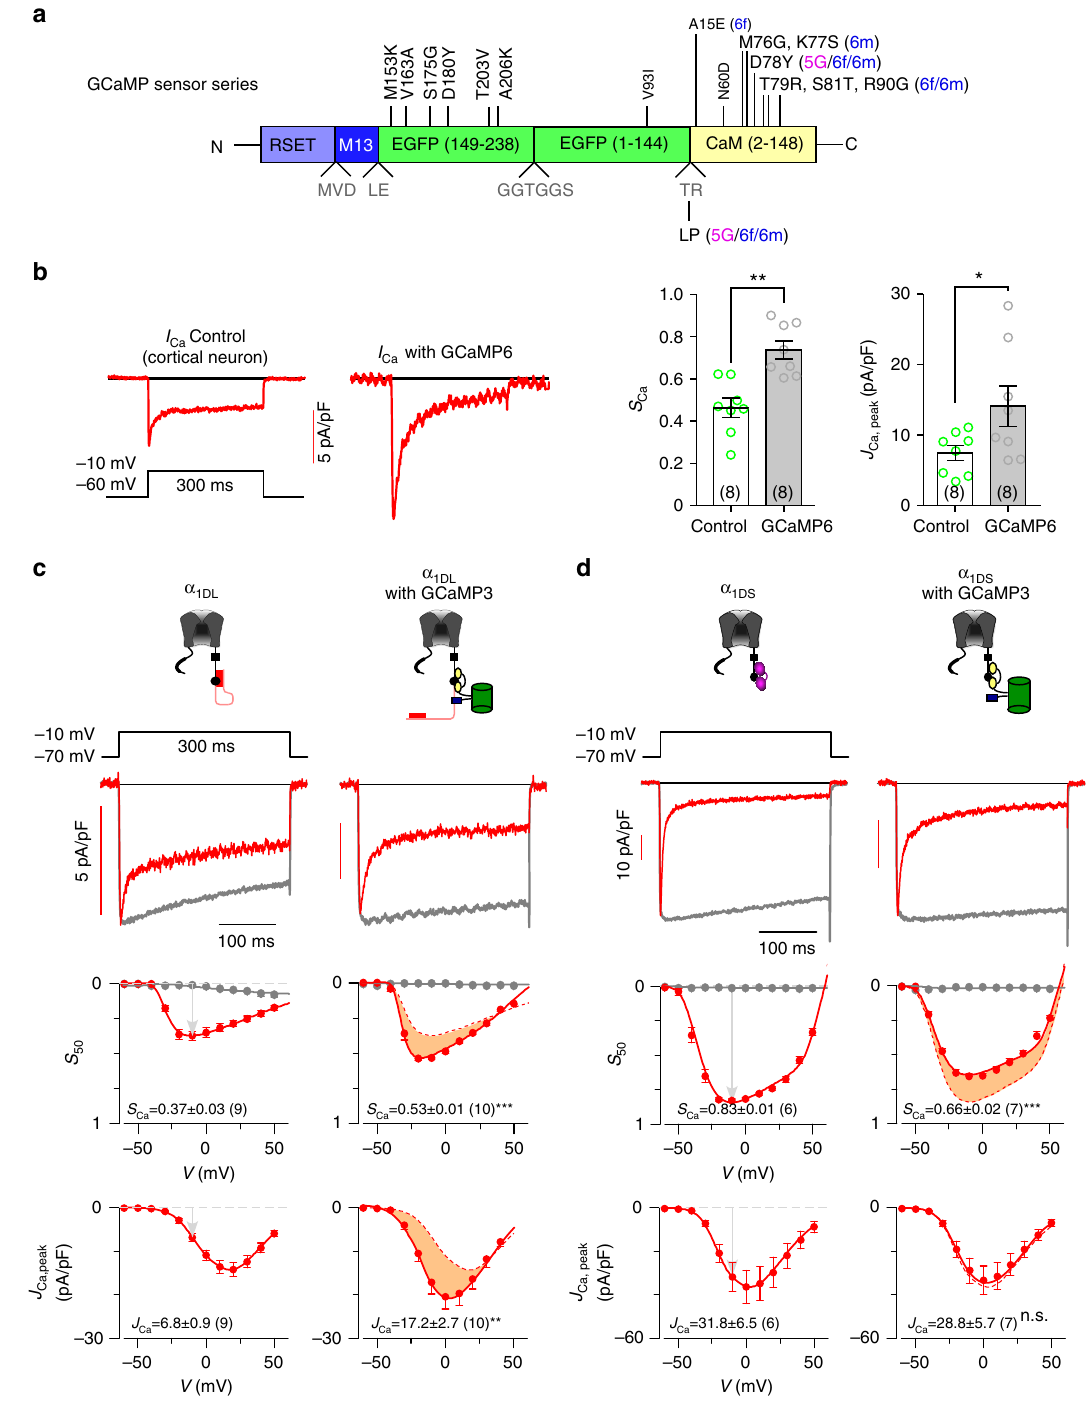
Fig. 2 GCaMP interferes with Ca V 1.3 gating. a Schematic summary of GCaMP series. Upgrades of GCaMP (from GCaMP3 to GCaMP5 and GCaMP6) were achieved by mutations of the EGFP and CaM domains at the sites indicated by vertical letters (GCaMP3 vs. GCaMP), or by horizontal letters (GCaMP5G/ 6f/6m vs. GCaMP3). Details see Supplementary Fig. 1. b Effects on I Ca were examined for neurons infected with AAV- Syn -GCaMP6f. Representative traces of Ca 2 + current (left), S Ca and J Ca analyses (right) for native Ca V 1.3 in cortical neurons expressing GCaMP6. Neurons were treated with a cocktail recipe to isolate Ca V 1 current (mostly Ca V 1.3) and recorded at the membrane potential ( V ) of − 10 mV. S Ca (quanti fi ed as 1 − I Ca,50 / I Ca, peak , where I Ca,50 and I Ca, peak represent the currents measured at 50 ms and the instantaneous peak, respectively) and J Ca (pA/pF, the current density of I Ca, peak ) serve as the indices for CDI and VGA respectively. c Effects of GCaMP3 on recombinant α 1DL . Representative Ca 2 + current traces were compared for I Ca recorded from HEK293 cells expressing long variant α 1DL alone (left), or with GCaMP3 (right) at − 10 mV. Ba 2 + currents (rescaled) and Ca 2 + currents ( I Ca ) were shown as grey and red traces, respectively, with scale bars indicative of I Ca amplitudes. CDI ( S Ca ) and VGA ( J Ca ) pro fi les at different membrane potentials are compared between α 1DL control and α 1DL overexpressed with GCaMP3 (differences highlighted by orange areas). d Effects of GCaMP3 on recombinant α 1DS alone (left), or with GCaMP3 (right), in a similar fashion to c . Standard error of the mean (S.E.M.) and Student ’ s t -test (two-tailed unpaired with criteria of signi fi cance: * p < 0.05; ** p < 0.01 and, *** p < 0.001) were calculated when applicable, and n.s. denotes “ not signi fi cant